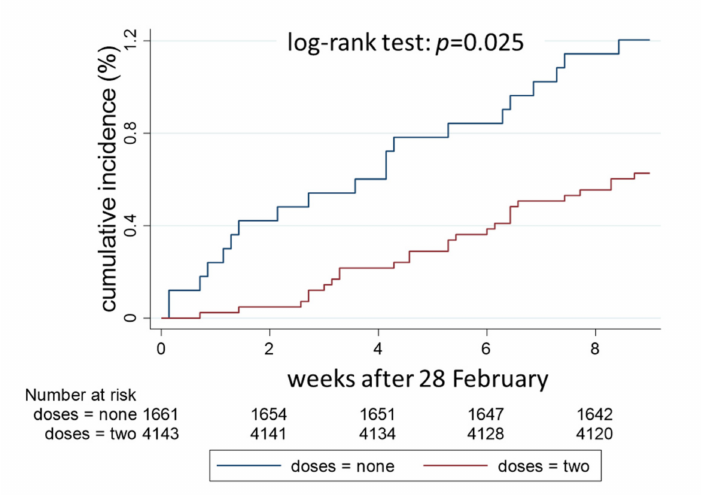
Figure 3. Cumulative incidence of SARS-CoV-2 infections in 5804 HWs of the University Hospital of Verona, Italy, estimated by the Kaplan–Meier method. HWs not administered any vaccine ( n = 1661, blue line) were compared with HWs who had received two doses at least 14 days before the 28 February 2021 ( n = 4143, red line). Table 4. Influence of vaccination on the risk of SARS-CoV-2 infection in 5804 HWs, either unvacci- nated during the study period ( n = 1661) or fully vaccinated with two doses at least 14 days before 28th of February 2021. The hazard ratio and p values were computed via the Cox regression model, controlling for sex, age, and job task.